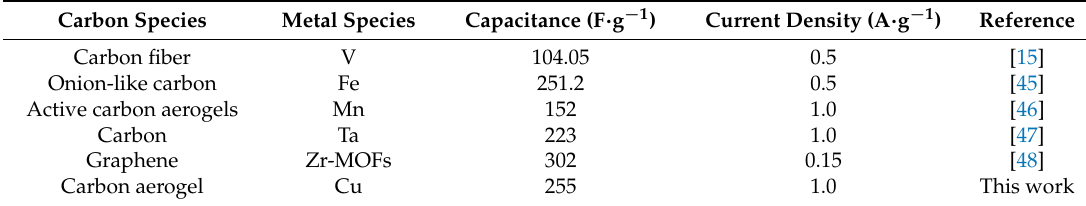
Table 5. Comparison of the specific capacitance of different carbon